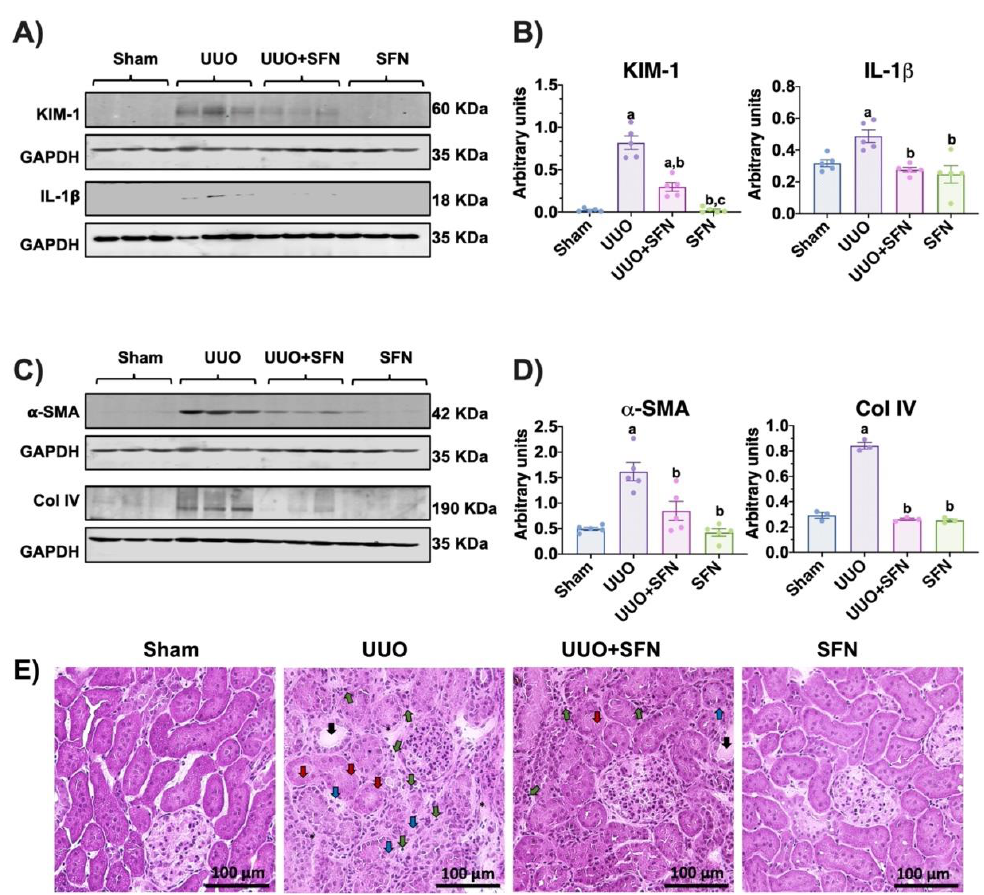
Figure 2. Sulforaphane (SFN) reduces kidney damage in the unilateral ureteral obstruction (UUO) model. ( A ) Representative immunoblotting and ( B ) densitometric analysis of kidney damage markers: kidney injury molecule-1 (KIM-1) and interleukin-1 beta (IL-1 β ). ( C ) Representative immunoblotting and ( D ) densitometric analysis of fibrotic markers’ alpha-smooth muscle actin ( α -SMA) and collagen IV (Col IV). Data are mean ± SEM, n = 5 per group (except for Col IV, n = 3), using a one-way ANOVA. Statistical differences were determined with multiple comparisons using Tukey’s test. Glyceraldehyde 3-phosphate dehydrogenase (GAPDH) was used as a loading control. a p < 0.05 vs. Sham, b p < 0.05 vs. UUO, c p < 0.05 vs. UUO + SFN. ( E ) Representative hematoxylin and eosin (H&E) staining of the kidney cortex. The H&E staining revealed that UUO induced the loss of tubular structure, characterized by the loss of epithelial cells (red arrows), tubular dilatation (black arrows), and necrosis (blue arrows). UUO also induces polymorphonuclear and lymphocyte infiltration (green arrows) and the presence of connective tissue between the tubules (asterisks). The SFN treatment partially decreased kidney injury despite some necrotic areas, and leukocyte infiltration was observed. Scale bar = 100 µ m. n = 3 for sham and SFN; n = 4 for UUO and UUO + SFN. Sham: simulated surgery without ligation of the ureter; UUO: unilateral ureteral obstruction with double ligating the left ureter for seven days; UUO + SFN: UUO treated with SFN (1 mg/kg, intraperitoneal) and SFN administered with SFN (1 mg/kg,